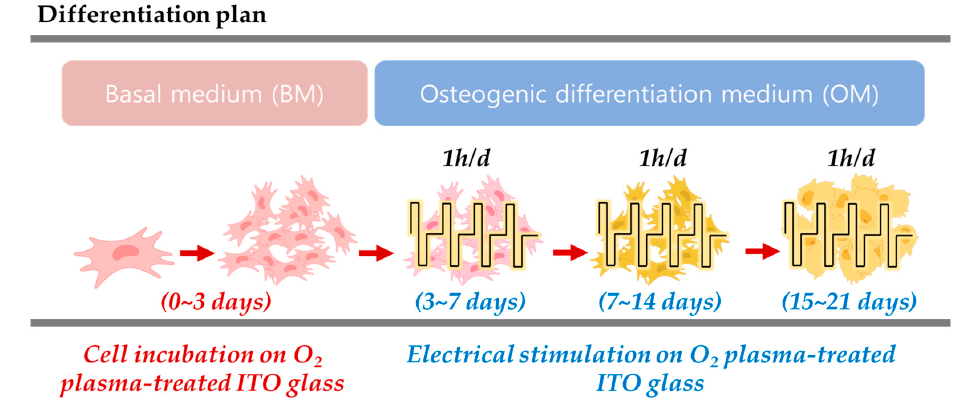
Figure 8. The osteogenic differentiation procedure under electrical stimulation.